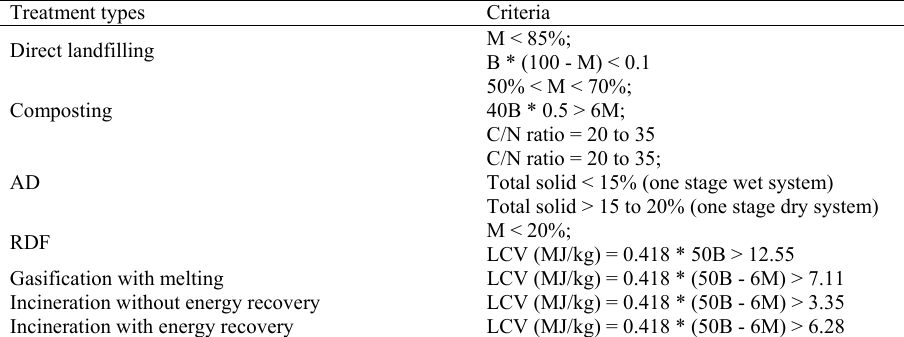
Table 1: Criteria for suitability assessment